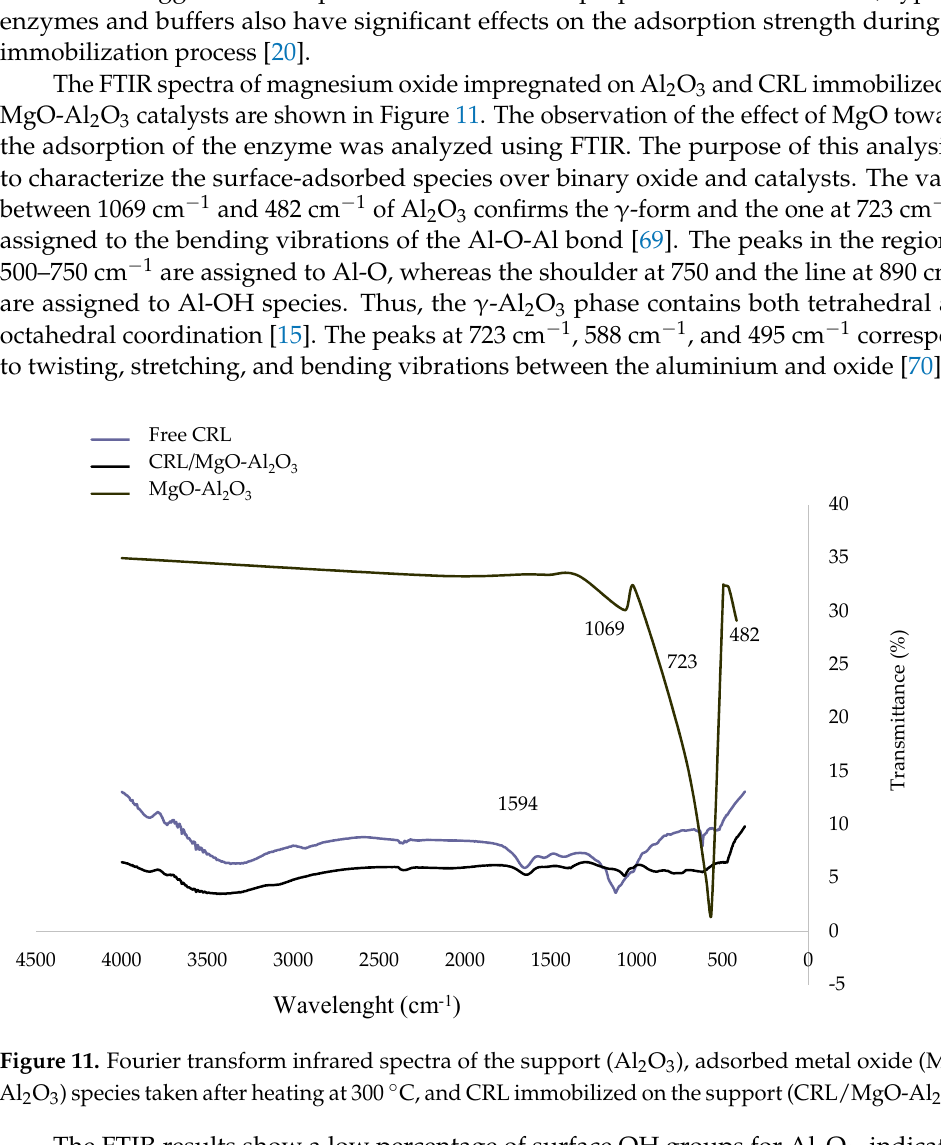
Figure 10. TGA-DTA spectra of the ( a ) support (Al 2 O 3 ), ( b ) adsorbed metal oxide (MgO-Al 2 O 3 )